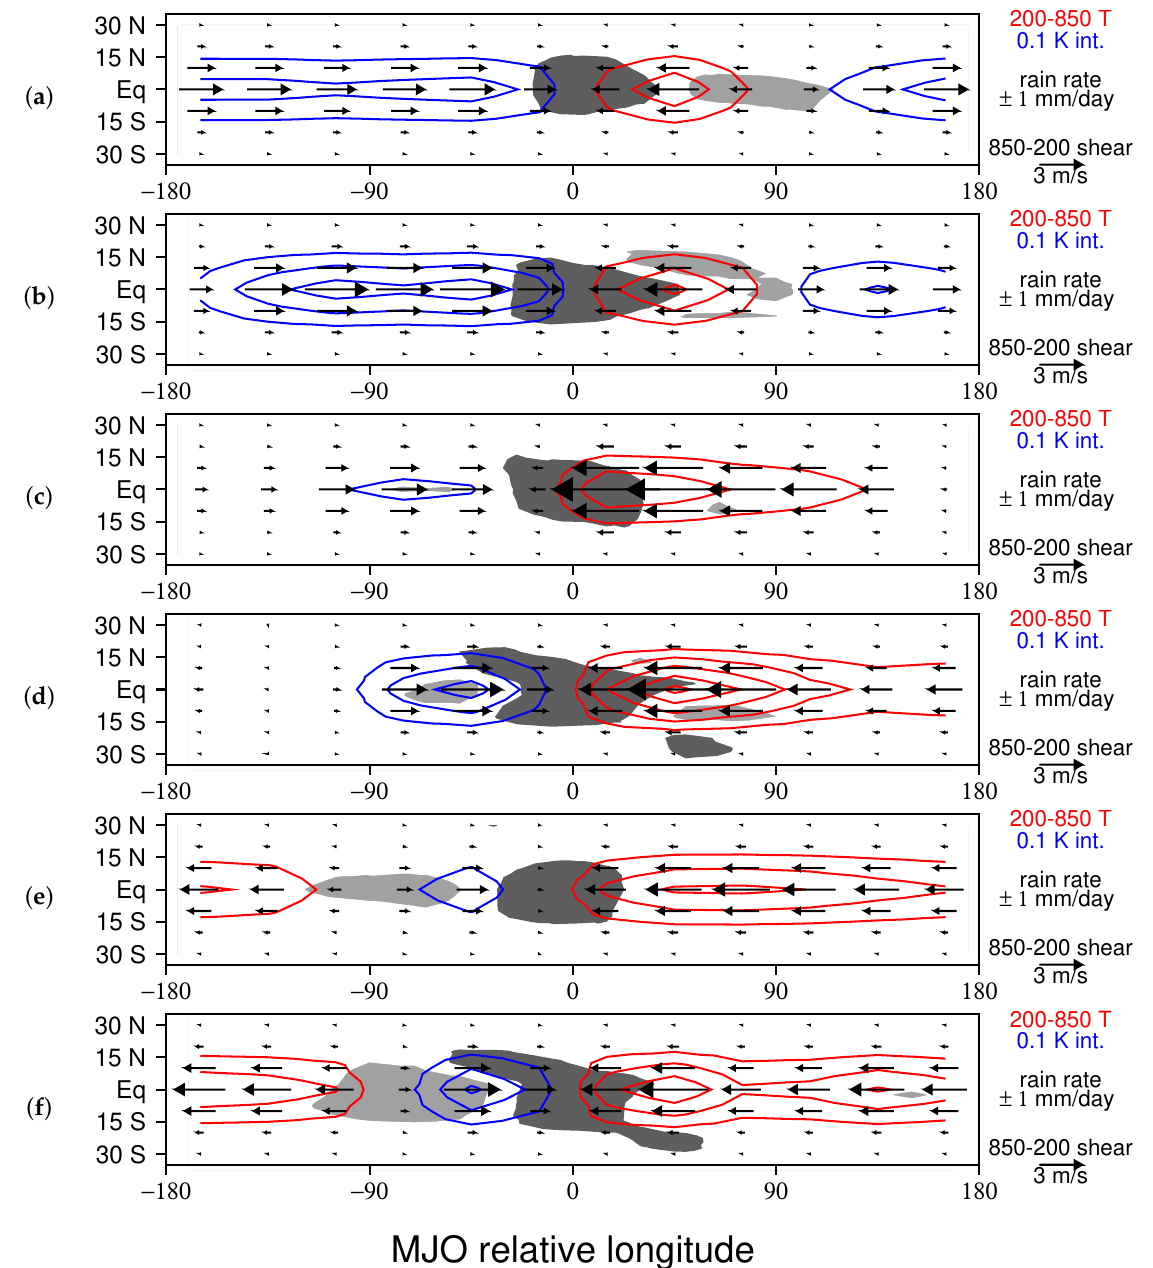
Figure 3. Average 200–850 hPa temperature perturbations and the difference between 850 and 200 hPa flow for the Kelvin wave components of the composite LAM MJO ( a , c , e ) and the observed MJO ( b , d , f ) for the developing, mature, and dissipating stages of the convective envelope, respectively (contoured as in Figure 2). Regions of rainfall less than − 1 and more than 1 mm/day are shaded light and dark gray, respectively. Panels ( b , d , f ) are adapted from